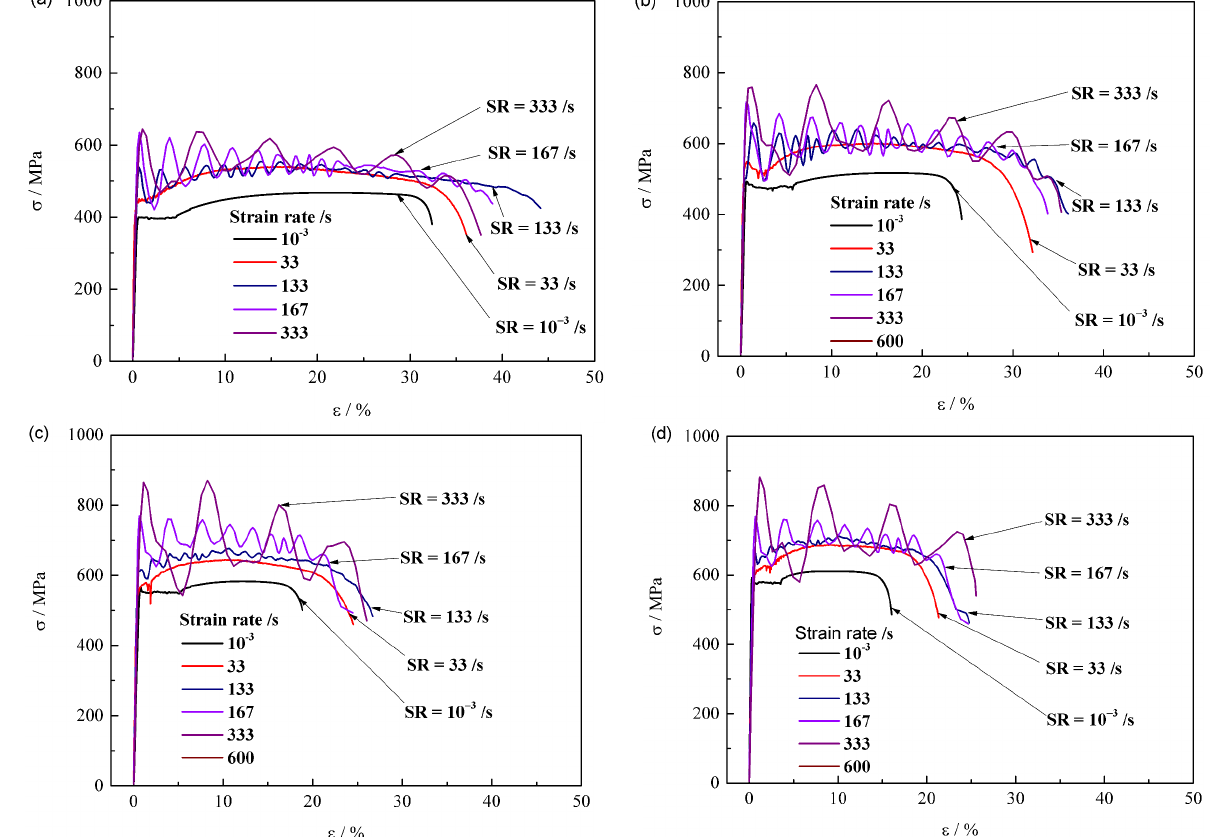
Figure 4. Stress–strain curves of longitudinal ( a ) Q380, ( b ) Q420, ( c ) Q460 and ( d ) Q500 at different strain rates.